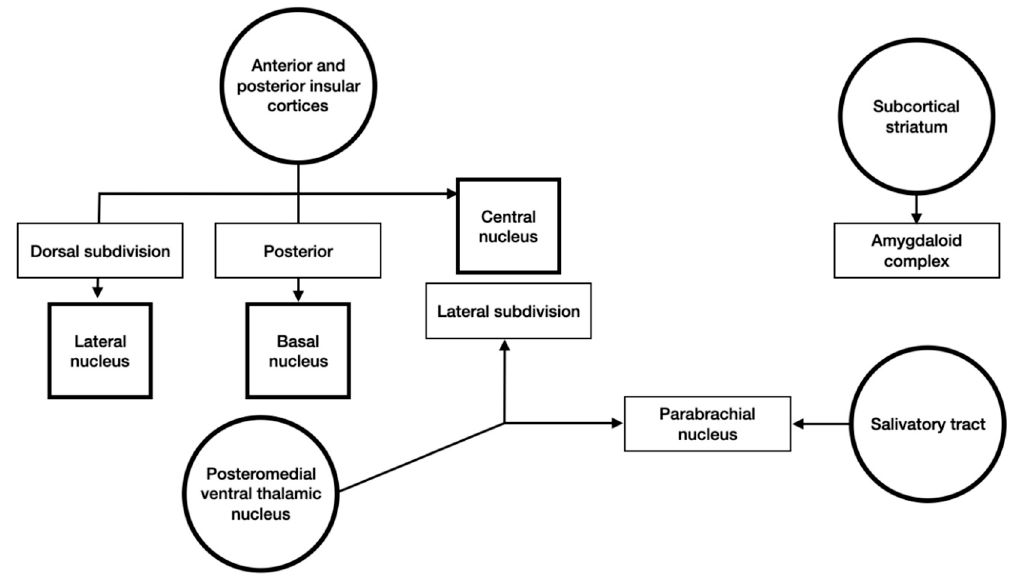
Figure 4. Schematic representation of gustatory and visceral inputs to the amygdala.